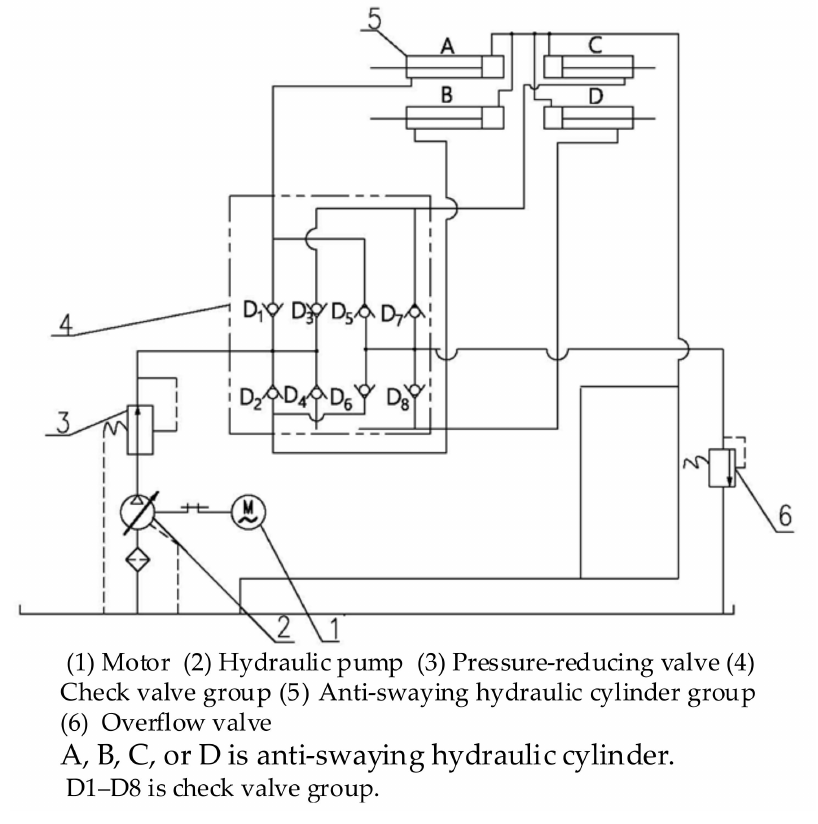
Figure 2. Hydraulic principle diagram of the hydraulic anti-swaying